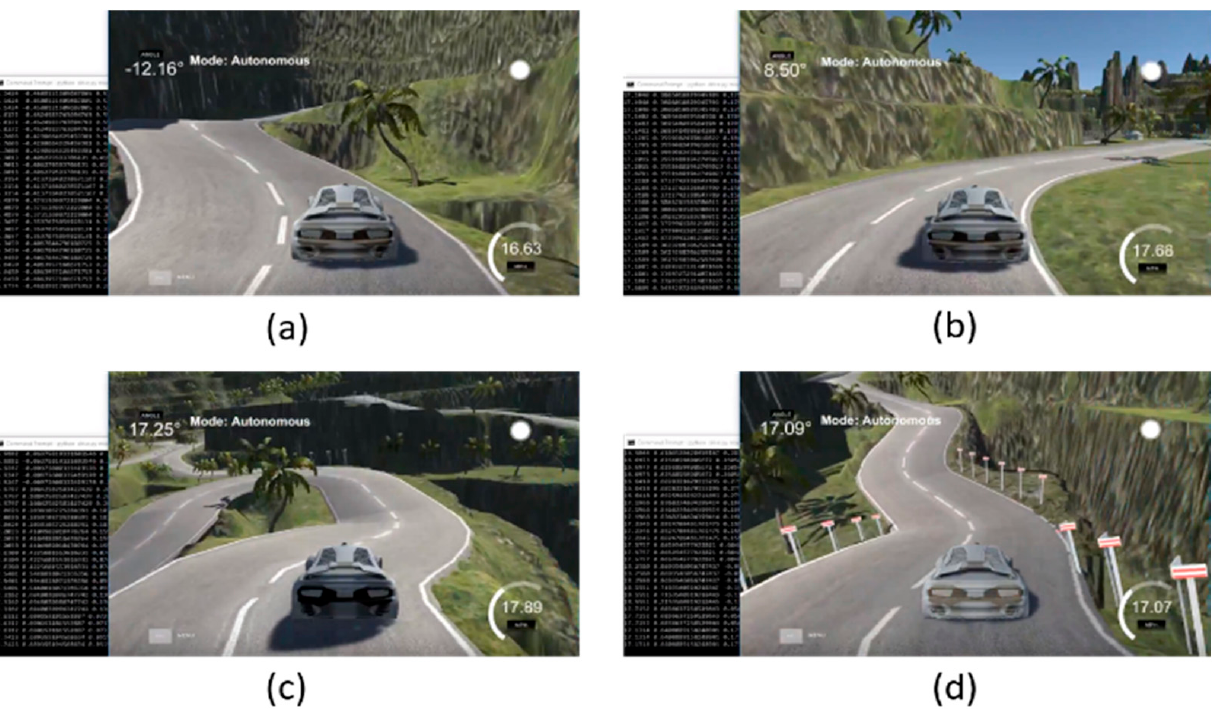
Figure 23. Performance of the model into autonomous mode ( a ) left turn prediction angle ( b ) right turn prediction angle ( c ) complex right turn prediction angle ( d ) hill tracked right turn prediction angle.